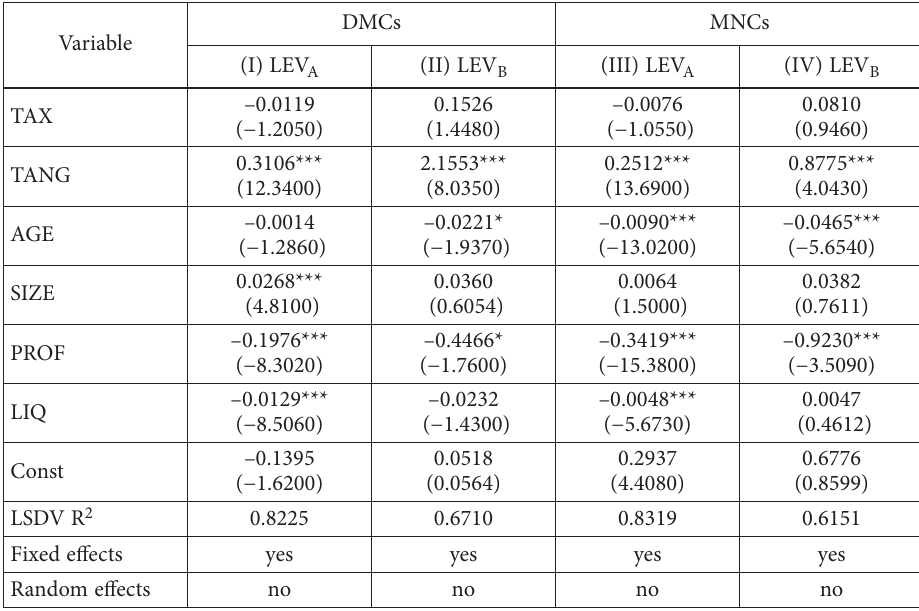
Table 5. Regression results: